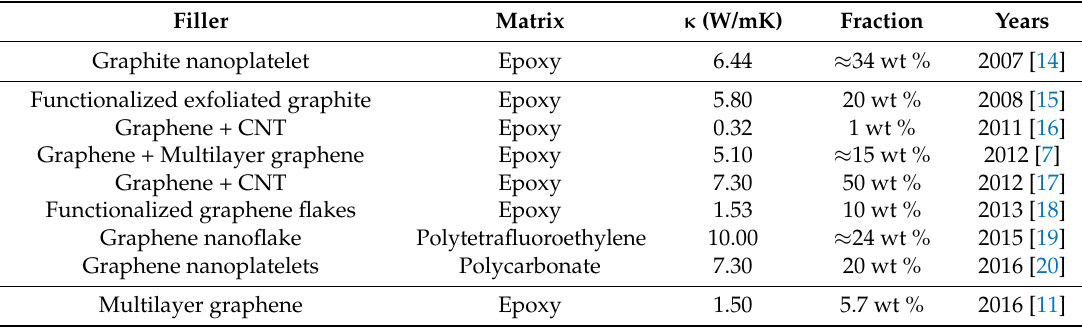
Table 1. Summary of graphene/polymers prepared by a solution or melt-blending process. Filler Matrix κ (W/mK) Fraction Years Graphite nanoplatelet Epoxy 6.44 ≈ 34 wt % 2007 [14] Functionalized exfoliated graphite Epoxy 5.80 20 wt % 2008 [15] Graphene + CNT Epoxy 0.32 1 wt % 2011 [16] Graphene + Multilayer graphene Epoxy 5.10 ≈ 15 wt % 2012 [7] Graphene + CNT Epoxy 7.30 50 wt % 2012 [17] Functionalized graphene flakes Epoxy 1.53 10 wt % 2013 [18] Graphene nanoflake Polytetrafluoroethylene 10.00 ≈ 24 wt % 2015 [19] Graphene nanoplatelets Polycarbonate 7.30 20 wt % 2016 [20] Multilayer graphene Epoxy 1.50 2016